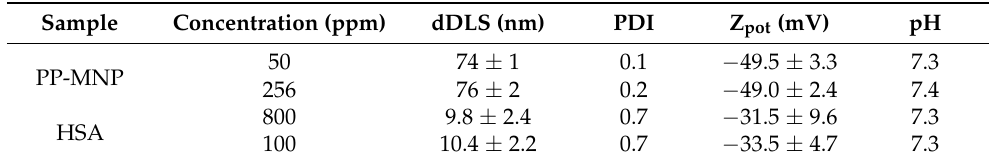
Table 3. Colloidal properties (hydrodynamic diameter, d DLS and Z potential, Zpot ELS ) of PP-MNPs and HSA.